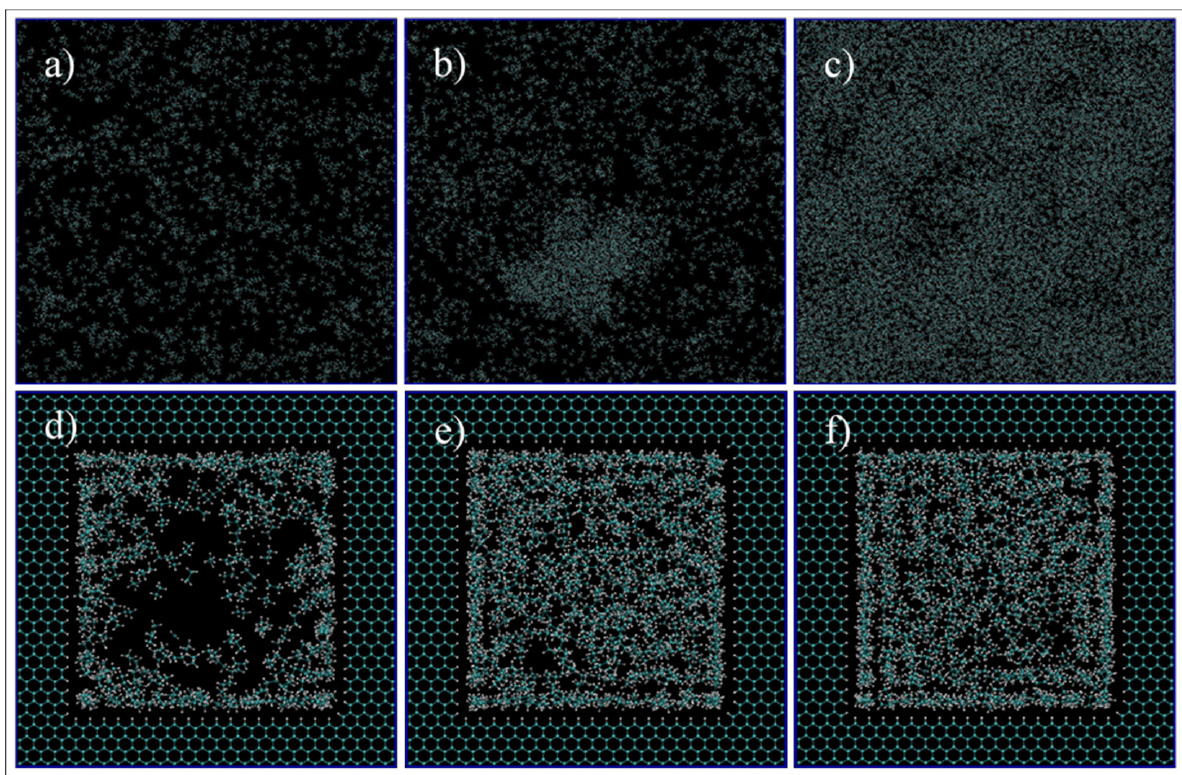
Figure 11. Ethane/Heptane mixture simulation in bulk ( a – c ) and pore medium ( d – f ) at C1 ( a , d ), C2 ( b , e ), and C3 ( c , f ) conditions.